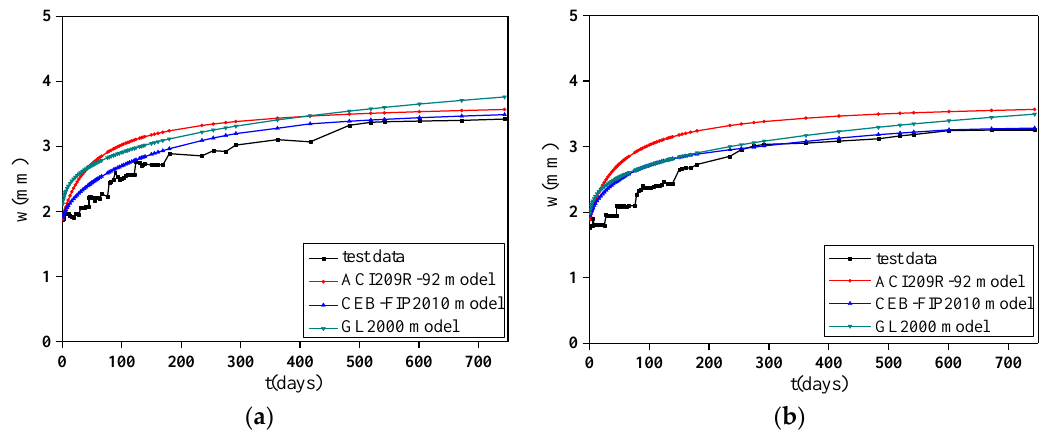
Figure 16. Comparison between the calculated values and the test values of each model for NAC beams under a low stress ratio. ( a ) Specimen D0/0-L; ( b ) Specimen G0/0-L.